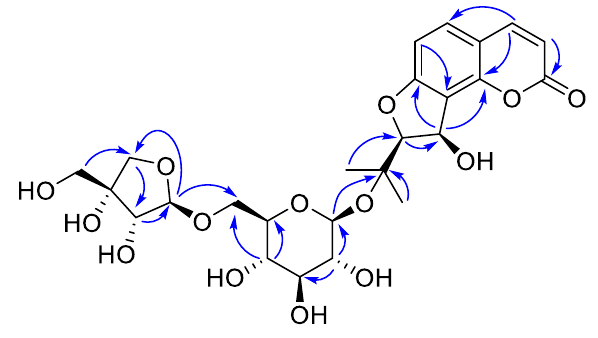
Fig. 2 Key HMBC correlations of 6 00 - O - b - D -apiofuranosylapterin ( 1 )